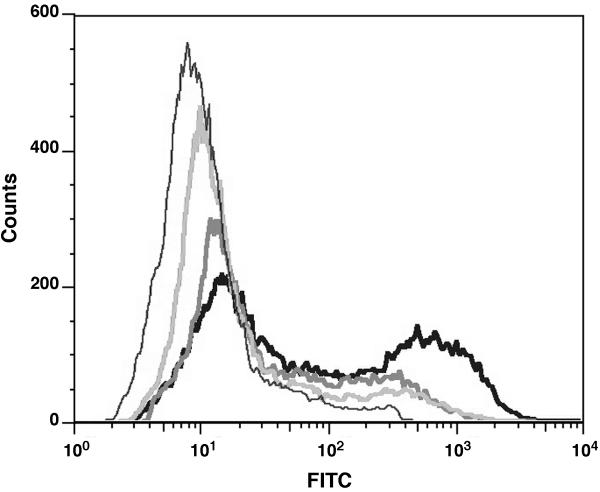
Cre-mediated recombination in primary splenocytes. Splenocytes from ROSA-26R mice were treated with 0 (thin black line), 1.0 (light grey line), 2.0 (dark grey line) and 5.0 (thick black line) μM HNC recombinase in serum free media for 2 hours. The cells were washed, cultured for 24 hours, stained with a fluorescent β-galactosidase substrate (ImaGene green™, C12FDG) and analyzed by flow cytometry. Cre-mediated recombination, which activates the expression of a floxed lacZ gene, results in increased fluorescence.